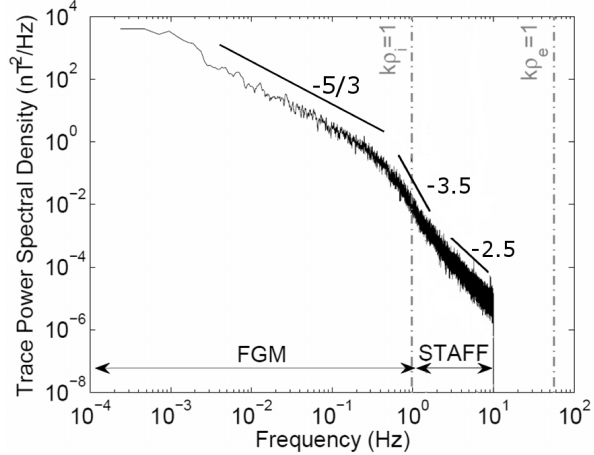
Fig. 2. Double-kink pattern produced by the MHD/WDR/strongly dispersive turbulence transitions. Kinetic Alfv´en wave spectra are given for the case of a weakly turbulent regime. In the case of a strongly turbulent regime, spectral indices − 4 and − 2.5 should be replaced by − 3 and − 7/3,